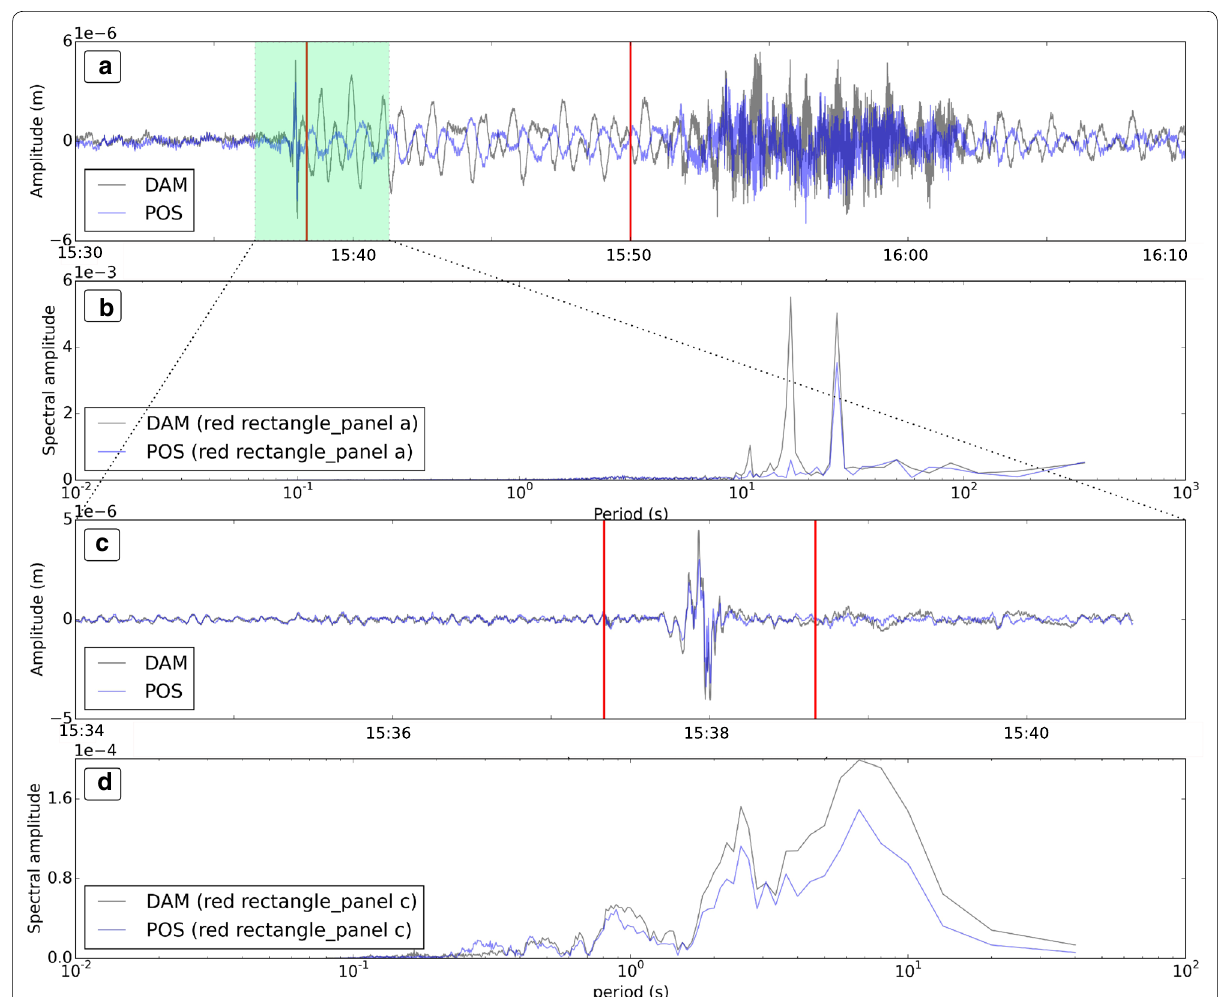
Fig. 4 VLPs and long-lasting oscillations at Kawah Ijen. a Vertical displacement and b spectra corresponding to the red window in ( a ). c Zoom on the first very-long-period (VLP) event and d spectra of the red window in ( c ). Instrument responses are deconvolved after detrending and high-pass filtering the data above 0.001 Hz. The dominant period of VLP signals is 8 s with superimposed low-amplitude shorter oscillations [down to 1 s period, subplot ( d )]. These long-lasting oscillations have distinct dominant periods at 17 s, 27 s and 50 s [subplot ( b